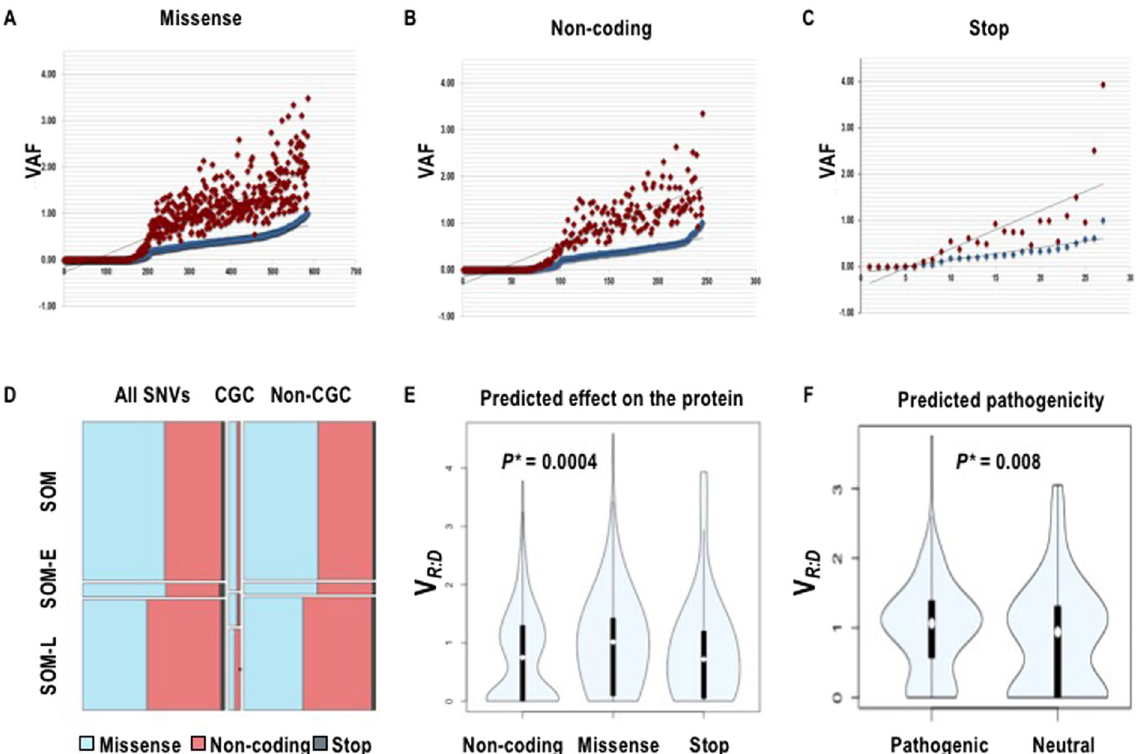
Figure 3. (A–C) Distribution of VAFtRNA (blue) and V R:D (red) in the subgroups of missense ( A ), non-coding ( B ) and stop-codon variants. The X axis shows the number of variants in each functional category. Positive correlation is seen in all three mutation groups. ( D ) Distribution of SOM-E and SOM-L expression status in regards to predicted effect on the protein function in the entire set, CGC-, and non-CGC variants. ( E ) V R:D for non-coding, missense and stop-codon variants across the entire dataset. Clearly different V R:D distribution is seen among the different functional subtypes, with the missense mutations showing higher V R:D , indicative for higher allele expression of potentially functional transcripts. ( F ) V R:D for pathogenic and neutral variants as predicted by FATHMM. The difference in the distribution is due to the larger proportion of the pathogenic mutations with higher V R:D